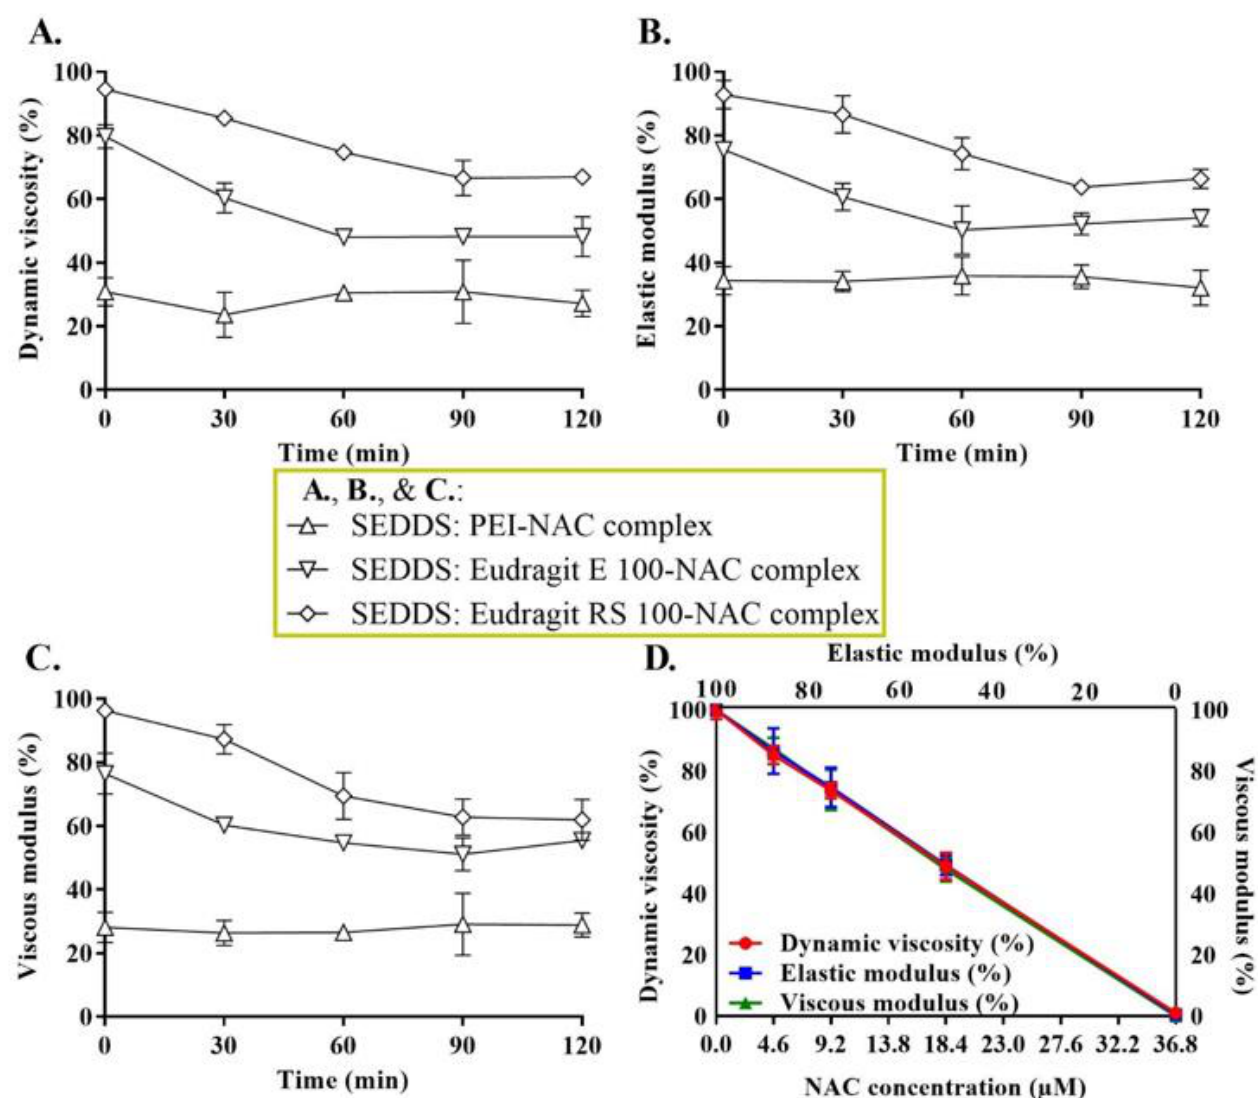
Figure 9. Viscoelastic changes over 2 h at 30-min intervals concerning dynamic viscosity ( A ), elastic modulus ( B ), and viscous modulus ( C ), influenced by different SEDDS complexes with 0.5–1.5% NAC loading, measured at 37 °C. The mucoactive SEDDSs in a ratio of 3:10 in 0.1 M phosphate buffer (pH 6.8) were admixed at 1:1 (vol./mass) with purified mucus. The associated viscoelastic changes of various NAC concentrations from mucolytic SEDDSs were addressed within the calibration curves ( D ) showing a gradient of changes in viscoelastic parameters affected by various NAC concentrations in the range of 0–36.8 µ M in the same buffer volume with the SEDDS added as a blank in the same weight of mucus described above. The calibration curves utilizing various NAC ratios or omitting NAC were treated as the positive or negative controls, respectively, and considered likewise incubation conditions and time as the test samples. Indicated values are the means ± standard deviations ( n ≥